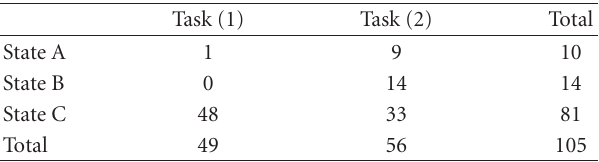
Table 1: Evaluation results (Agreement).